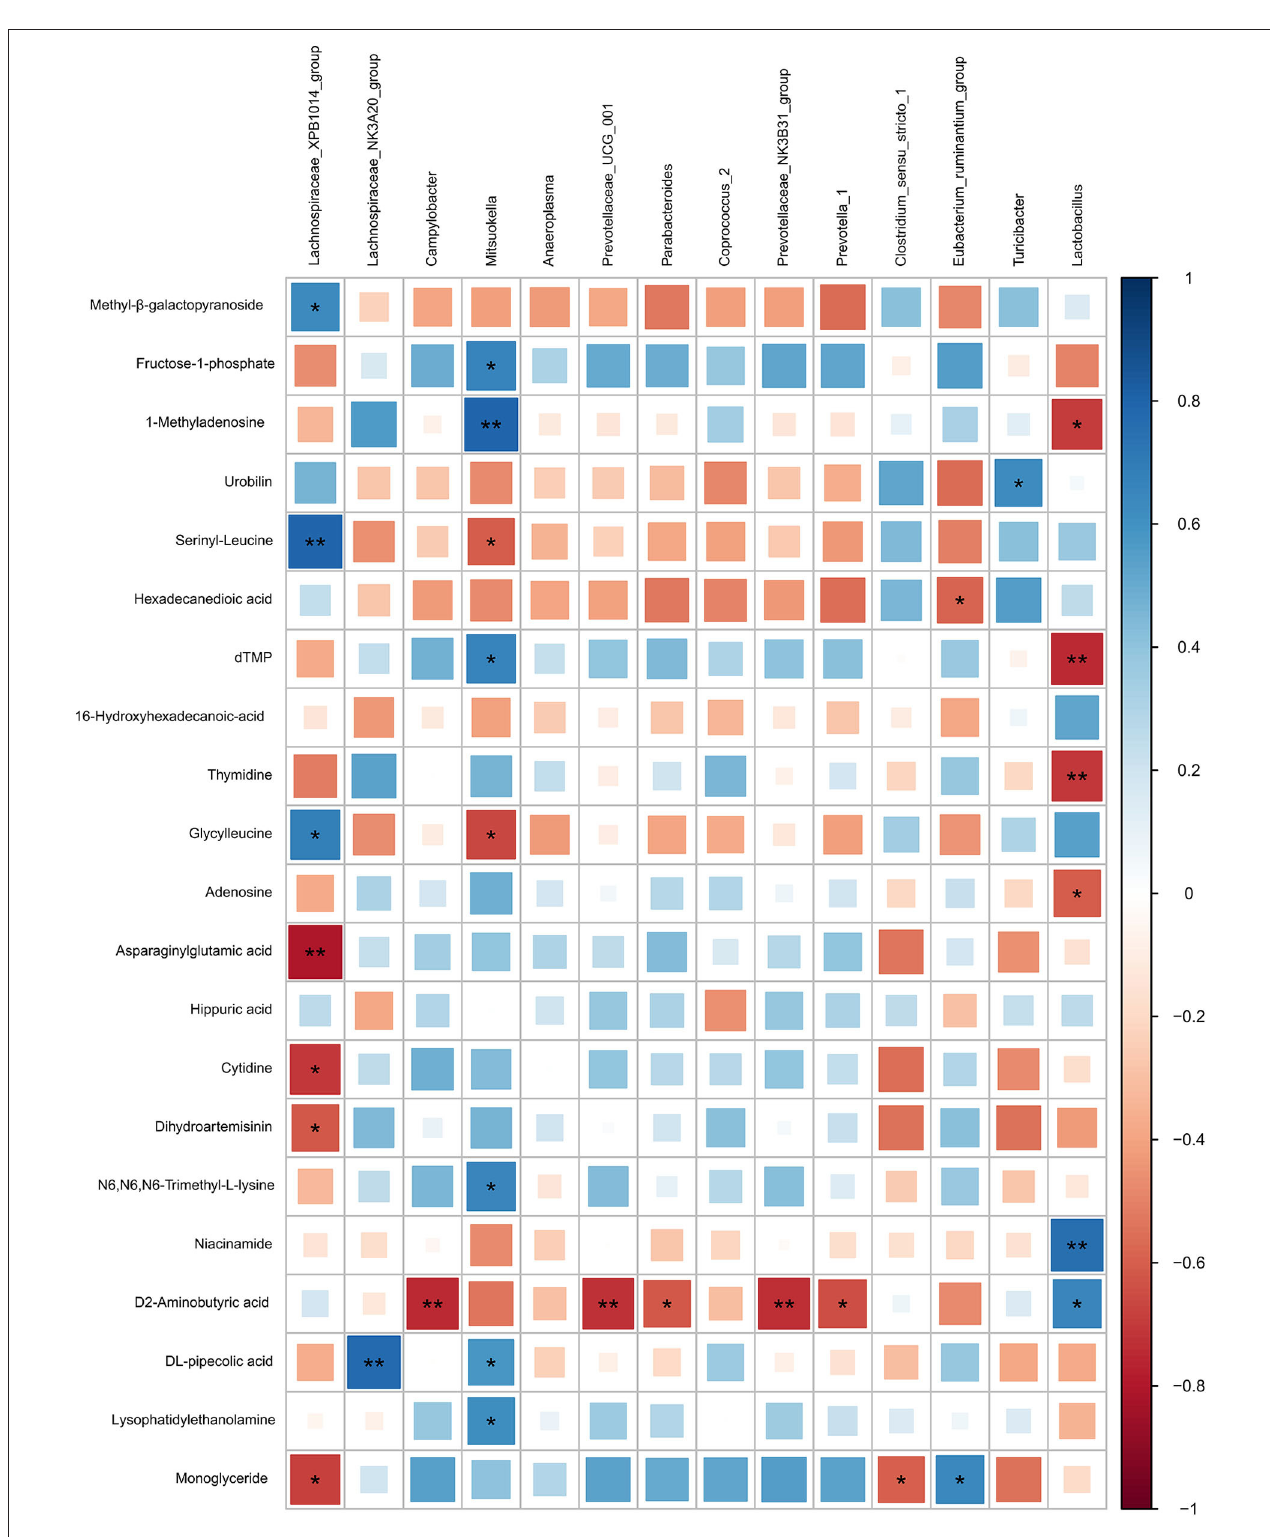
FIGURE 7 | Correlation analysis between the differential microbiota at the genus level with the differential features identified from the LC-MS metabolome in colonic digesta of growing pigs. Each row in the graph represents the differential features, each column represents a genus, each square represents a Pearson correlation coefficient between a genus and a differential feature, while the area of each square represents the size of each correlation coefficient. Red color represents a negative correlation, while blue color represents a positive correlation. **Indicates a significant difference between the free access group and the time-restricted feeding group with P < 0.01; while *indicates a significant difference with P <